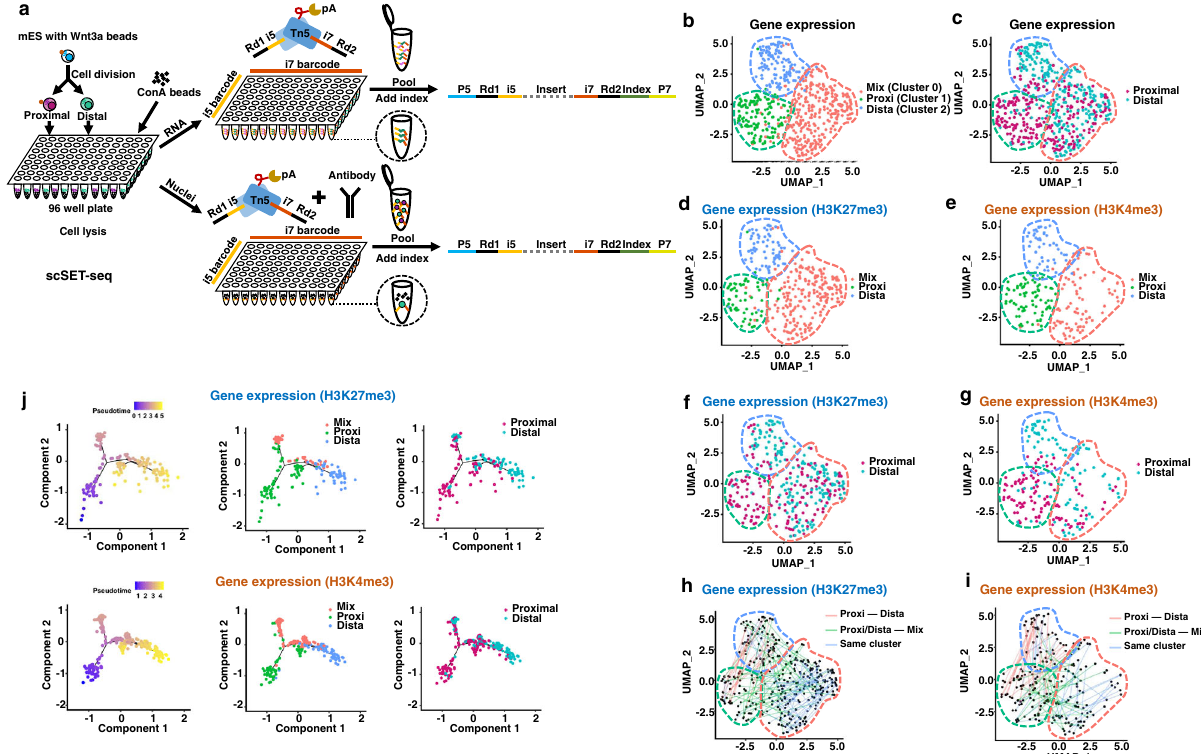
Fig. 2 scSET-seq is able to identify the cell clusters in Wnt3a beads induced asymmetric cell division in mESCs. a Schema showing the process of scSET-seq. Epigenome and transcriptome were indexed by transposomes before pooling and library construction. b Uniform Manifold Approximation and Projection (UMAP) embedding showing the clustering of cells from H3K27me3 and H3K4me3 scSET-seq by gene expressions. To increase the reproducibility, the gene expressions of H3K27me3 and H3K4me3 scSET-seq were merged for clustering. Each dot represented a single cell. See main text for the de fi nition of clustering name. c Colored map showing the relative position of cells to Wnt3a beads. Cells proximal to beads were marked garnet and distal to cells were marked cyan. d , e UMAP clustered cells were subdivided into H3K27me3 scSET-seq ( d ) and H3K4me3 scSET-seq ( e ). f , g Colored map showing the relative position of cells to Wnt3a beads in H3K27me3 scSET-seq ( f ) and H3K4me3 scSET-seq ( g ). Cells proximal to beads were marked garnet and distal to cells were marked cyan. h , i Paired daughter cells were lined up showing their distributions among cell clusters. Two daughter cells from the same parental cell were identi fi ed by their index in H3K27me3 scSET-seq ( h ) and H3K4me3 scSET-seq ( i ). Red lines indicated the paired cells were between Proxi and Dista cluster, green lines indicated the two daughter cells were between Proxi/Dista cluster and Mix cluster, and blue lines connected cells inside the same cluster. j Pseudotime analysis of single-cell lineages using H3K27me3 and H3K4me3 scSET-seq transcriptional data. The left panels showed the pseudotime scores across the branches. The cell clusters were marked in the middle panels. Relative positions to Wnt3a beads were marked in the right panels. Source data are provided as a Source Data fi